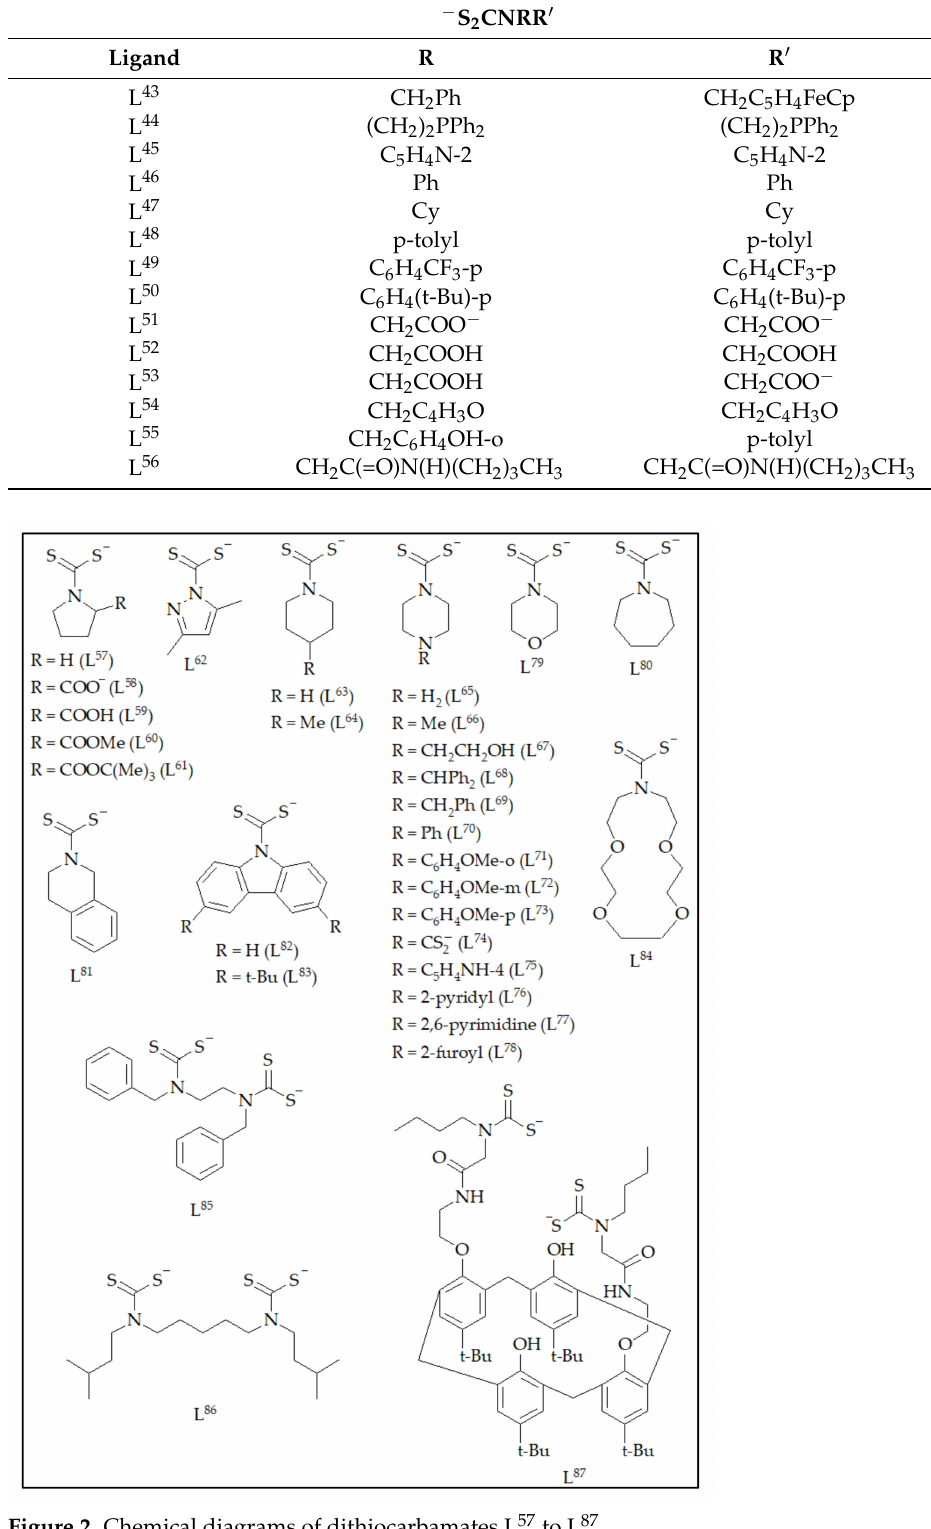
Figure 2. Chemical diagrams of dithiocarbamates L 57 to L 87